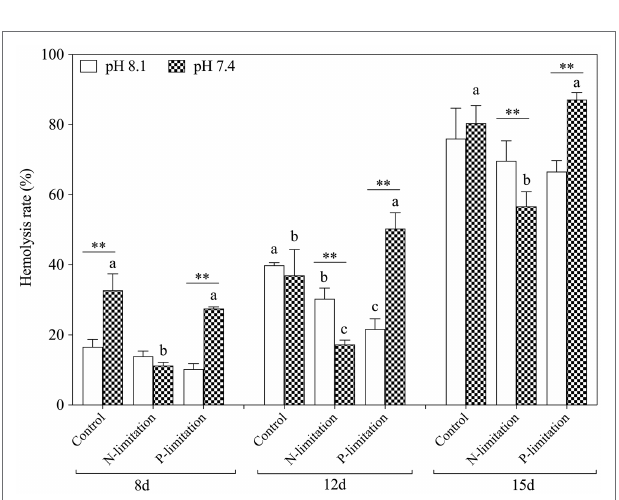
FIGURE 7 | Changes in hemolytic activity in K. mikimotoi under seawater acidification conditions when exposed to different nutrient levels. Data are presented as means ± SD. Different lowercase letters indicate significant differences among three nutrient levels within each pH treatment at each time point ( p < 0.05). Asterisks indicate significant differences between two pH levels within each nutrient treatment ( p < 0.05).